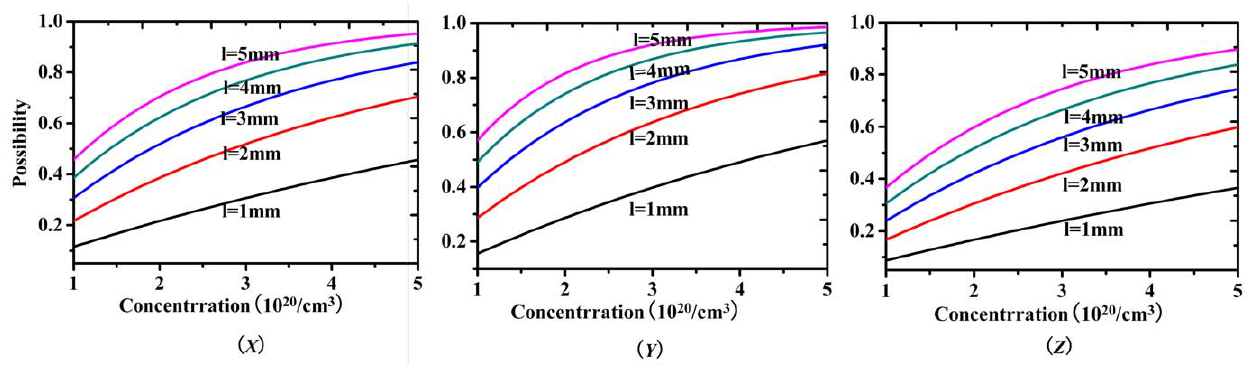
Figure 8. Relationship between the Yb 3 + doping concentration and the re-absorption possibility at different absorption path length l when l =980 nm for the different polarizations in Yb 3 + :KBaGd(MoO 4 ) 3 crystal.